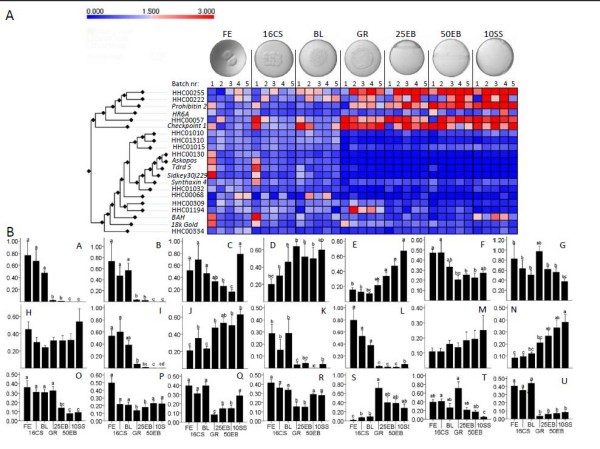
Gene class discovery. A: Clustering of genes, according to their relative gene expression during early embryonic development in Atlantic halibut. Genes were clustered using the single-linkage method with Pearson correlation coefficient as distance measurement. The developmental stages were fertilized eggs (FE); 8-cell stage (8CS), 8 hours past fertilization (hpf); 16 cell stage (16CS), 12 hpf; blastula (BL), 45 hpf; germ ring (GR), 82 hpf; 25% epiboly (25EP) 96 hpf; 50% epiboly (50EP), 117 hpf; and 10 somite stage (10SS), 142 hpf (n = 5). Data was standardized against the first stage, fertilized eggs (FE). Colour bar indicates relative gene expression in relation to FE. Red colour shows up-regulation and blue colour down-regulation in relation to FE. Reference genes are not included. B: Relative gene expressions of selected genes from fertilization to 10 somite stage. Expression pattern of a. Askopos, b. Si:dkey-30j22.9, c. BAH, d. Checkpoint 1, e. Prohibitin 2, f. Synthaxin 4, g. 18 k hypothetical goldfish protein, h. HR6A, i. Tudor 5 protein, j. HHC00057, k. HHC00068, l. HHC00130, m. HHC00222, n. HHC00255, o. HHC00309, p. HHC00334, q. HHC01010, r. HHC01015, s. HHC01032, t. HHC01194, u. HHC01310. Error bars indicate the standard deviation (n = 5).